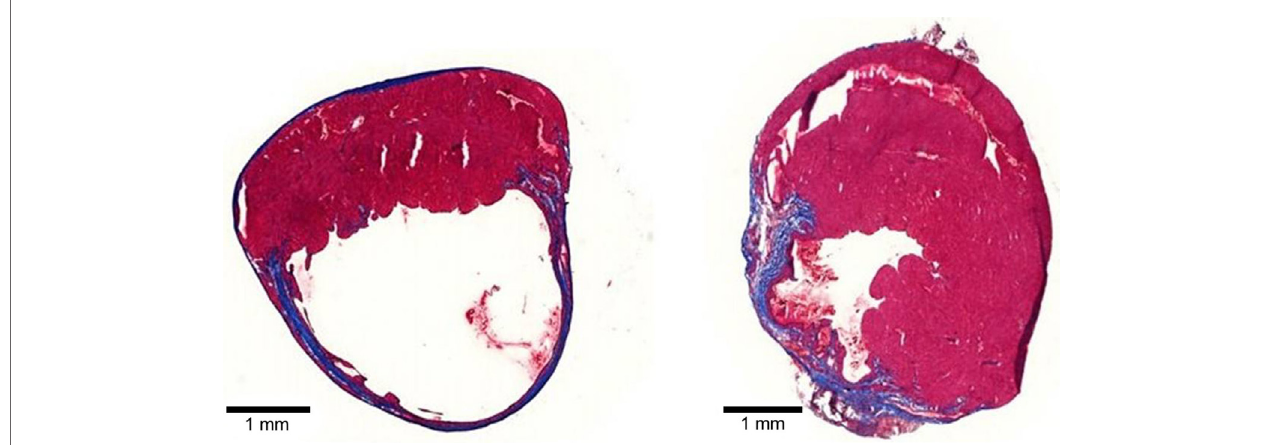
FiGURe 3 | Tissue sections of mouse Mi hearts injected with PBS (left) or type 1 collagen biomaterial (right) . Note the dilation and thinning of the collagen scar (blue tissue) in the PBS-treated heart, compared to the preservation of wall thickness and viable muscle (red) in the collagen biomaterial-treated